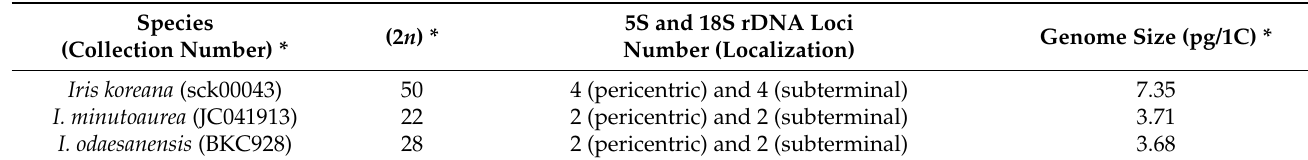
Table 1. Investigated species of Iris series Chinenses with collection numbers, 5S and 18S rDNA signal numbers and localization, chromosome numbers and genome size estimates.